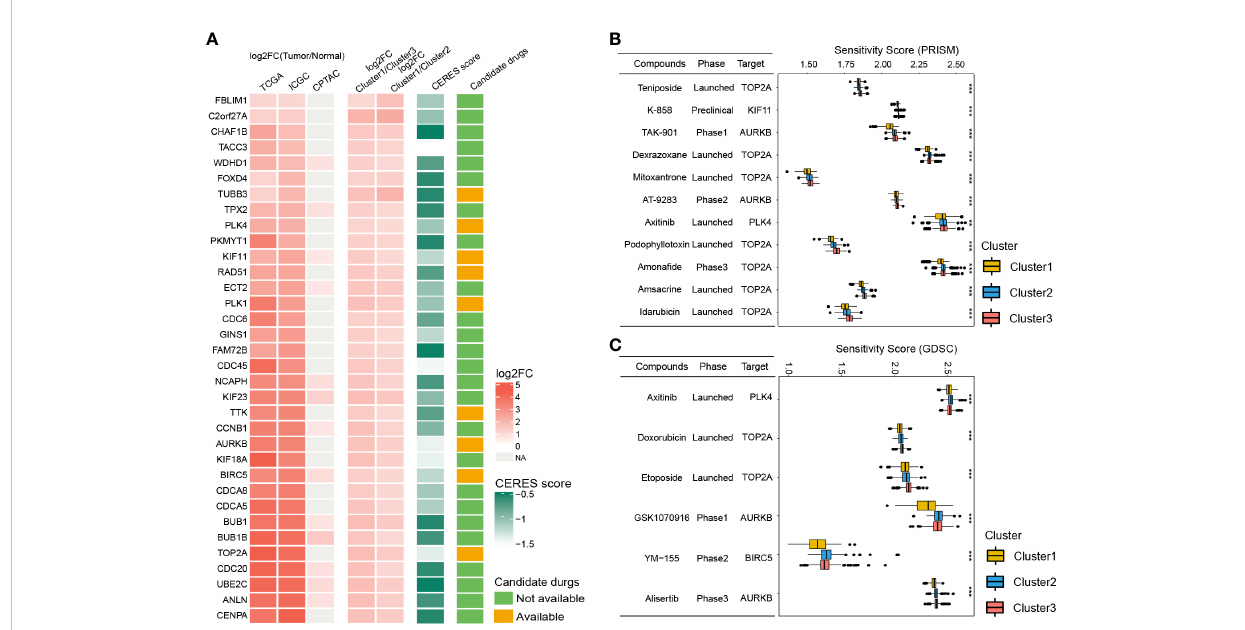
FIGURE 8 Identi fi cation of potential drug targets and candidate agents for Cluster1 HCC patients. (A) The 34 potential drug targets identi fi ed for Cluster1 HCC patients. (B and C) The sensitivity score, phase, and targets of candidate agents (eleven PRISM-derived compounds and seven GDSC-derived compounds) for Cluster1 HCC patients. **P<0.01;